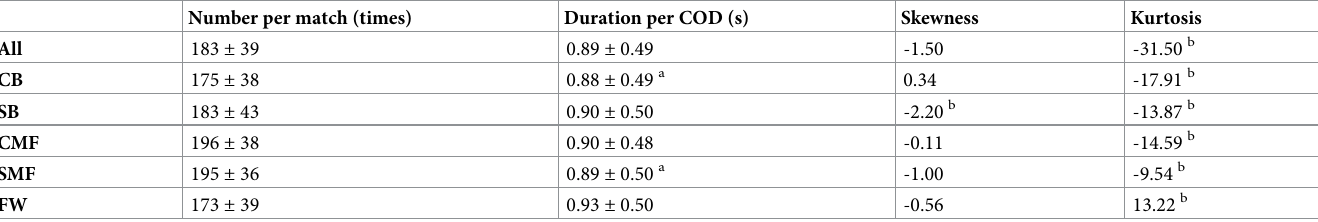
Table 2. Descriptive data on number of CODs, analytical duration, skewness and kurtosis of frequency distribution. Number per match (times)